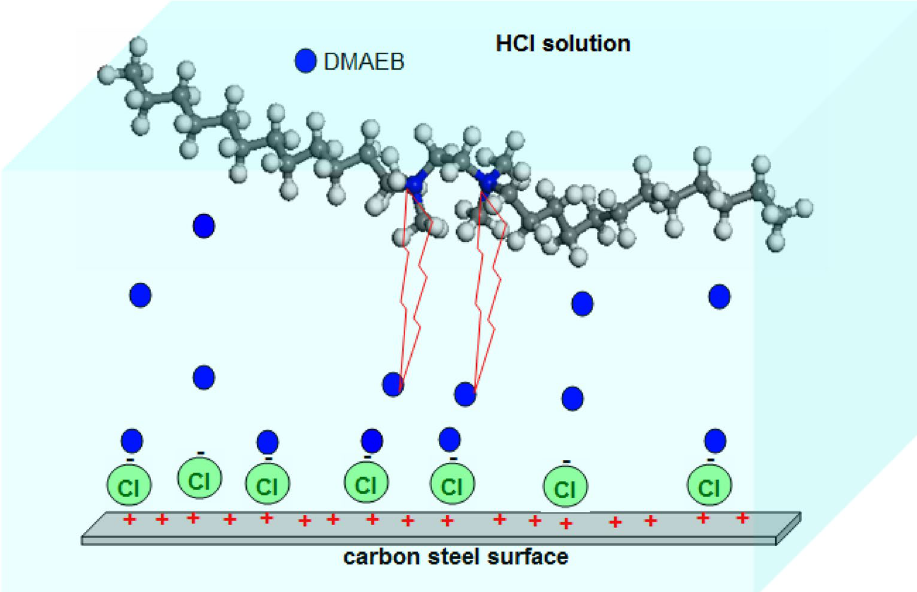
Figure 5. Schematic illustration of inhibition mechanism of DMAEB for N80 C-steel corrosion in 15.0% HCl solution.